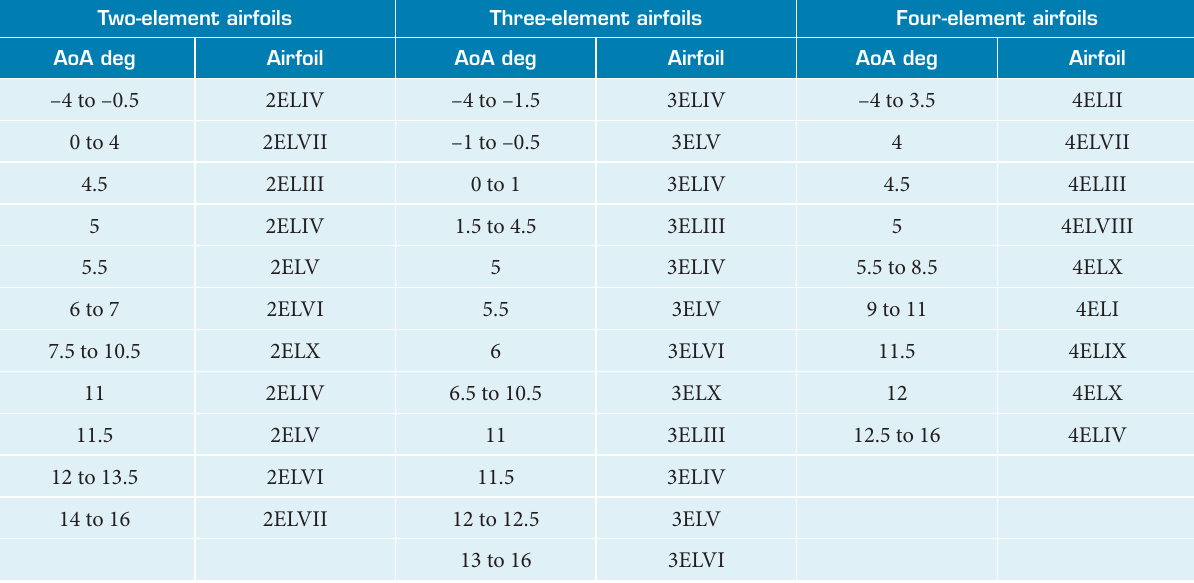
/ c ratio for Re = 2.5 × 10 5 . l d